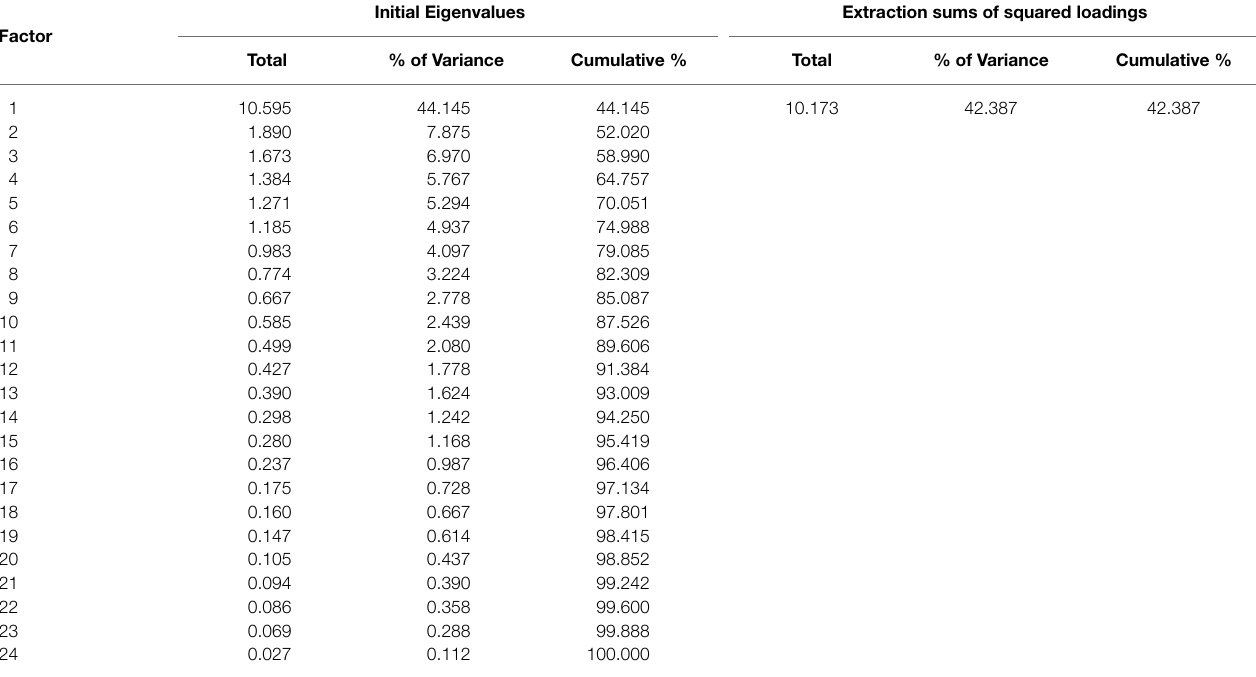
Factoring method = Principal Axis Factoring.